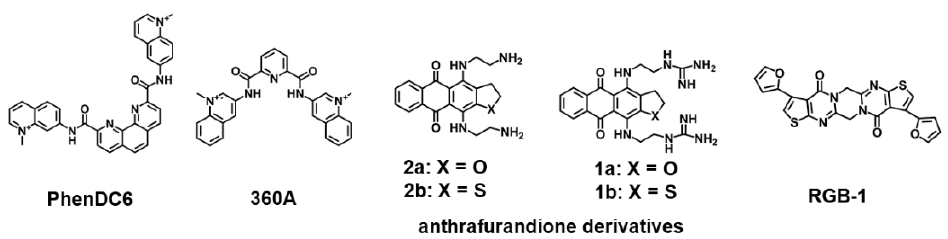
Figure 6. RNA G4-interacting ligands mentioned in this review showing the common name of the ligand and chemical structure.